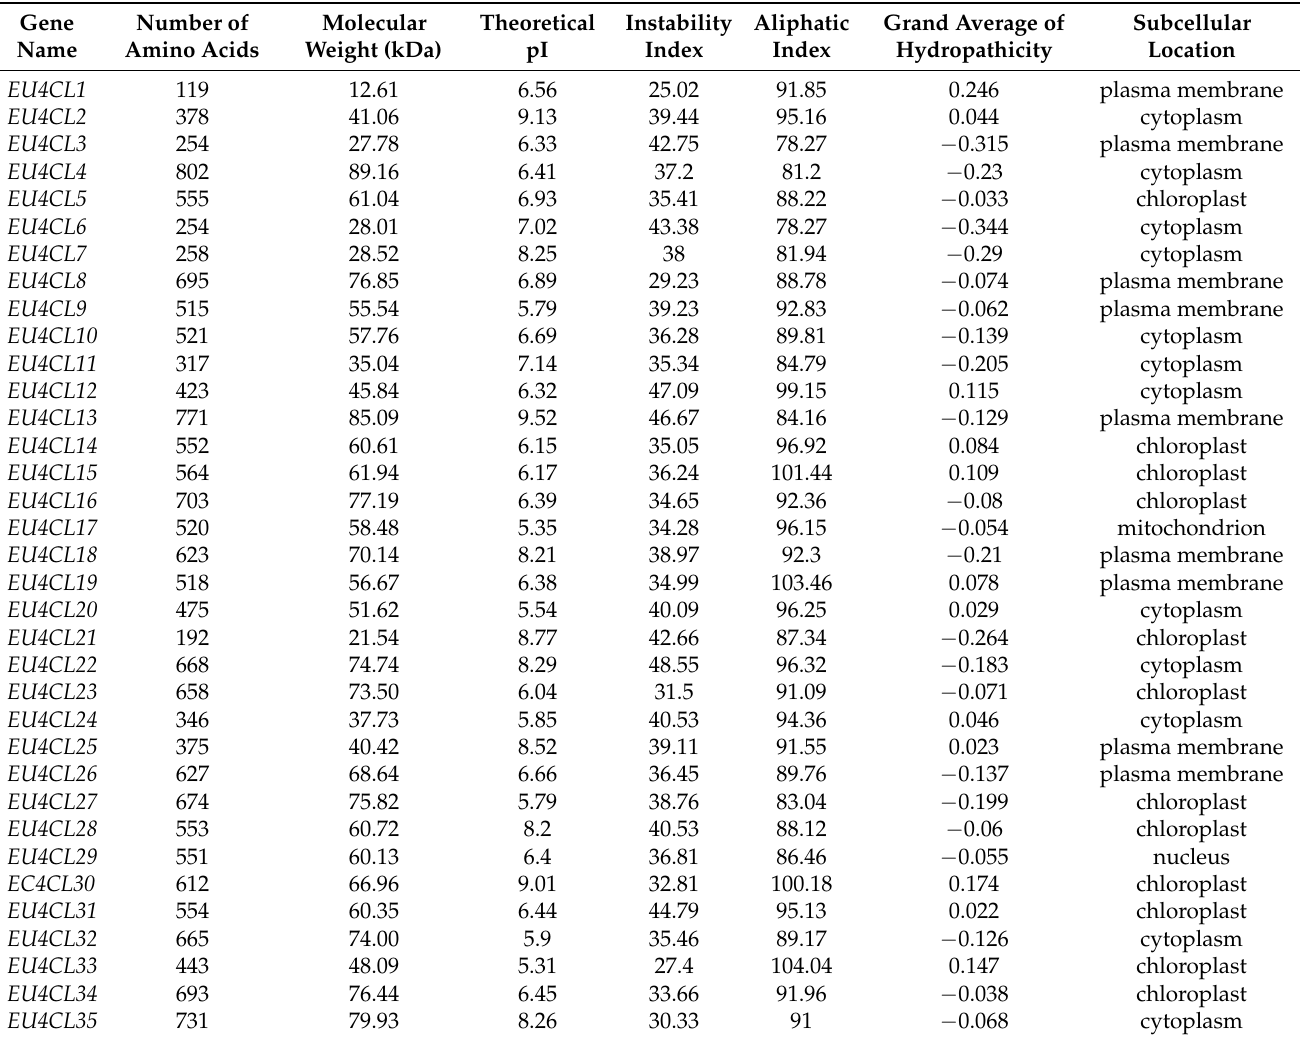
Table 2. Detailed physicochemical characteristics of 4CL proteins of Eucommia ulmoides